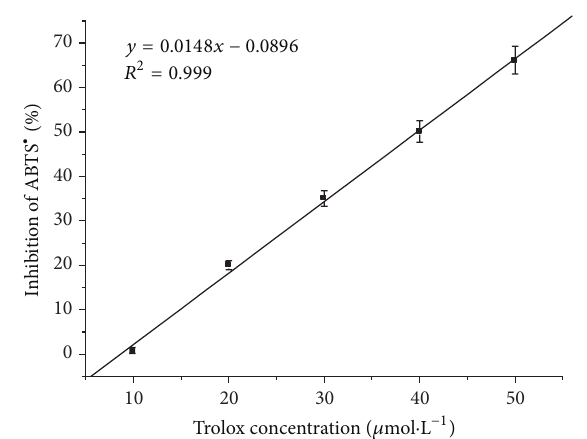
Figure2:ArepresentativecalibrationcurveofABTS ∙+ inhibitionby Trolox standards (10, 20, 30, 40, 50 𝜇 mol ⋅ L −1 ). 𝑌 = 0.0148𝑥−0.0896 and 𝑅 2 = 0.999 ( 𝑛 = 3